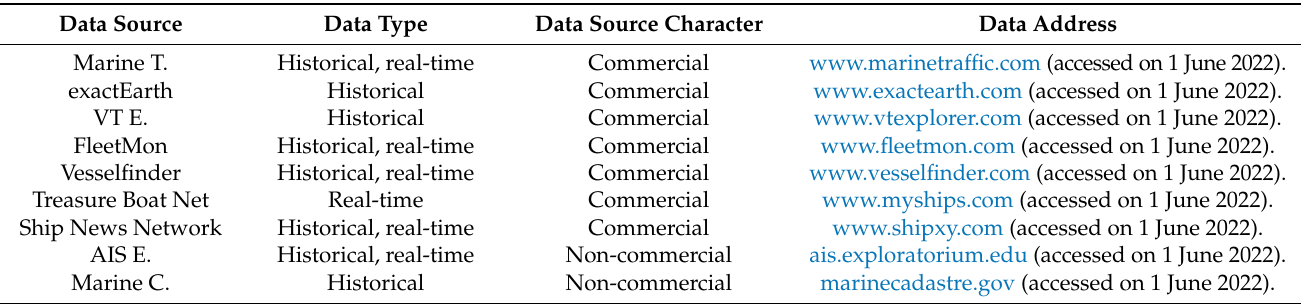
Table 4. AIS data sources and their